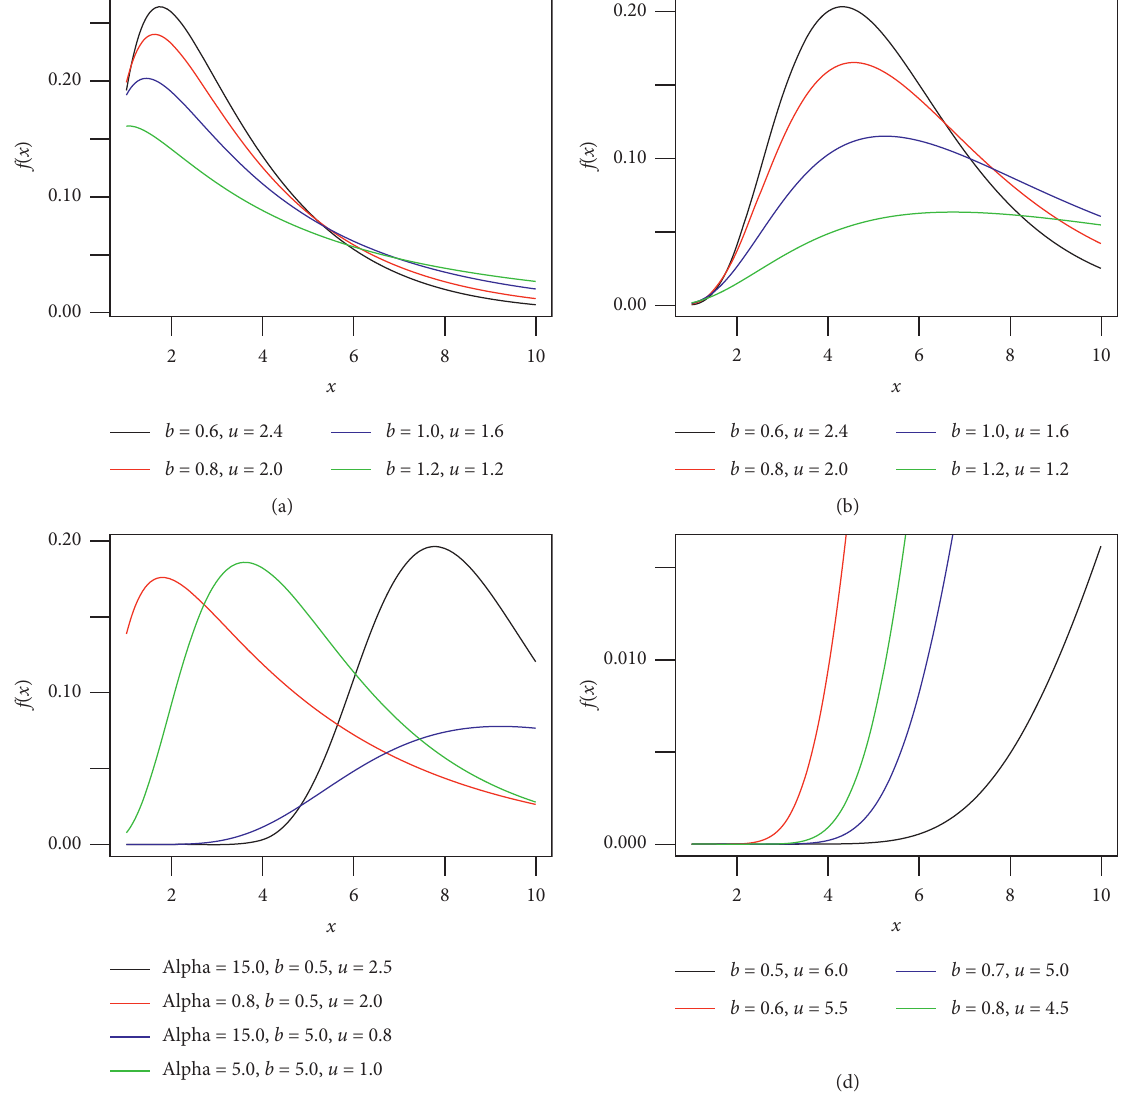
Figure 1: EEDL probability density function: (a) alpha � 0.8, q � phi � gamma � 2, (b) alpha � 3, q � phi � gamma � 2, (c) q � phi � gamma � 2, and (d) alpha � 8, u � phi � gamma �